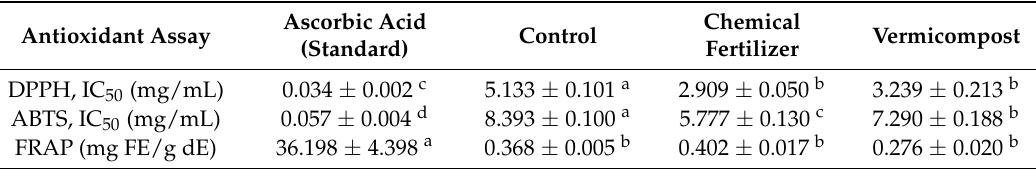
Figure 1. HPLC chromatograms of carotenoids in pineapple pulp extracts retrieved from plants treated with different types of fertilizers in the field. ( A ) control ( B ) chemical fertilizer ( C ) vermicompost. The peak height of less than 10 mAU was not detected. 239 Table 3. Antioxidant capacities determined by DPPH, ABTS, and FRAP assays in methanolic extracts of MD2 pineapple fruits produced from plants grown with different types of